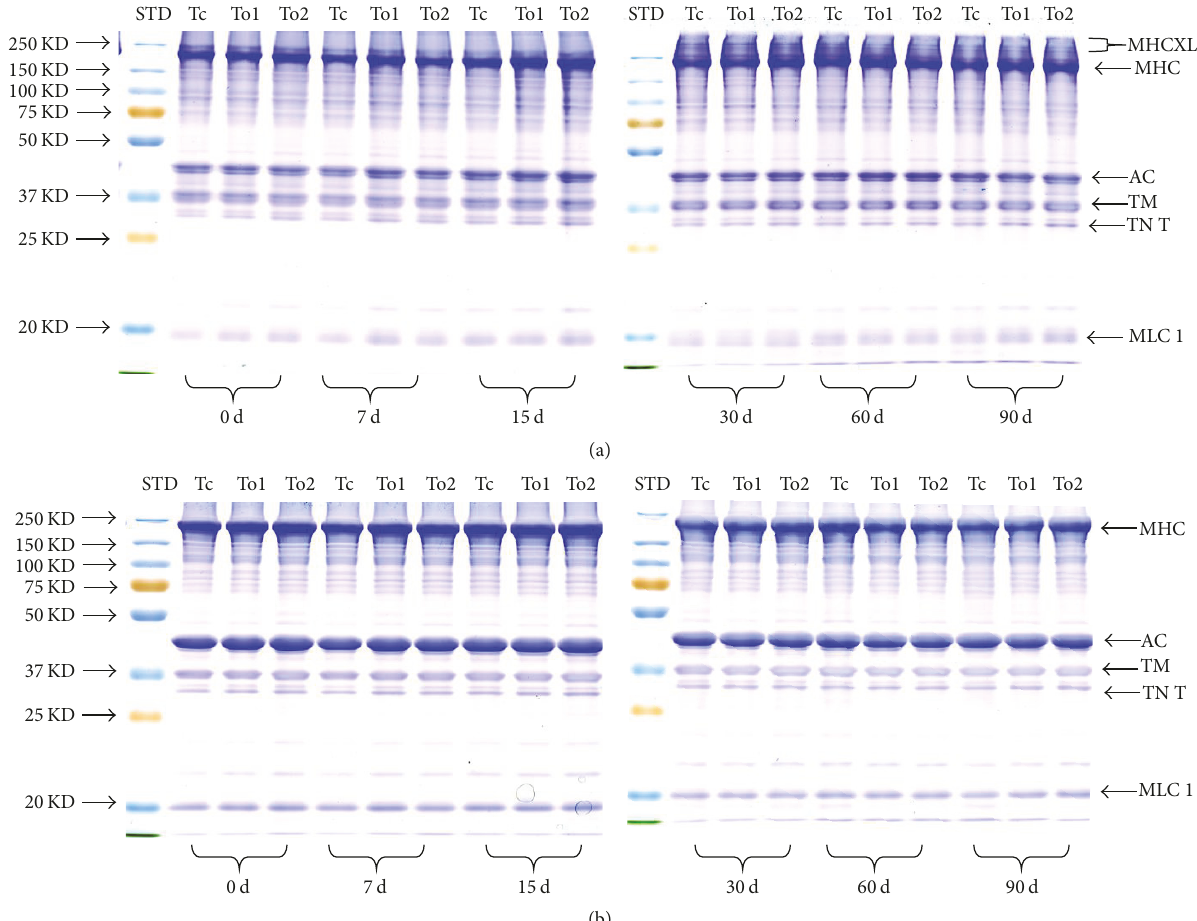
Figure 4: Change in protein patterns of silver carp surimi during frozen storage. Tc: two washing cycles using ice water only; To1: first and second washing cycle using ice water containing 8 mg/L ozone and ice water, respectively; To2: first and second washing cycle using ice water and ice water containing 8 mg/L ozone, respectively. (a) Protein sample was dissolved in loading buffer without 𝛽 -mercaptoethanol; (b) protein sample was dissolved in loading buffer with 𝛽 -mercaptoethanol; STD: kaleidoscope protein standard; MHCXL: cross-links of myosin heavy chain; MHC: myosin heavy chain; AC: actin; TM: tropomyosin; TN T: troponin-T; MLC 1: myosin light chain